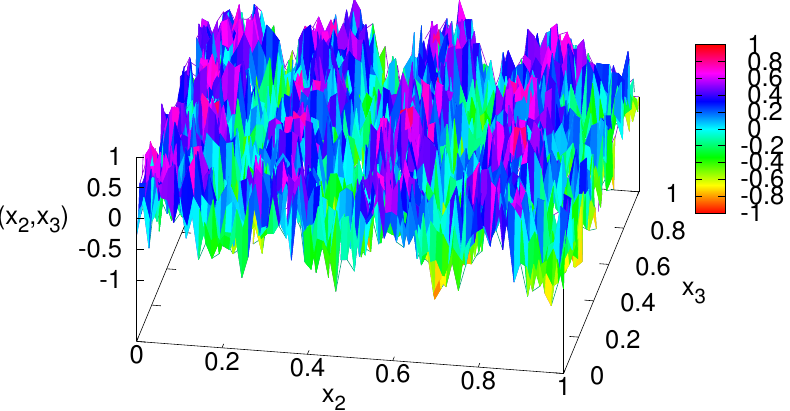
Figure 3. Sample harmonic distribution of volume force terms with phase and intensity random noise from Equation (7) ( N k =